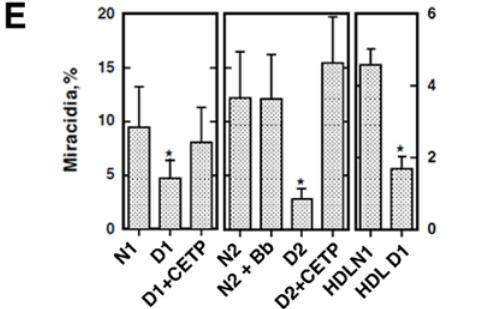
Figure 5. Lipoprotein requirement for embryonation of the S. japonicum eggs after eight days in culture [7–10]. ( A ): incubation of the eggs with and without human serum (10%) after pre-exposure of the parents while laying the eggs to 5% and 10% of human serum. Embryonation proceeds when the parents or eggs have access to adequate human serum.